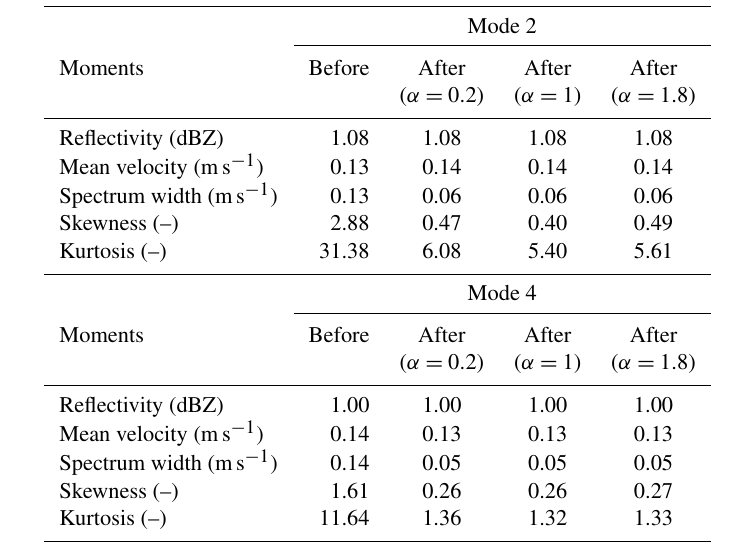
Table B1. Standard deviation (SD) for Ku-band spectral moments before and after the sidelobe removal compared with observations at mode 3. Radar observations from 4.5 to 6km are used for comparison.